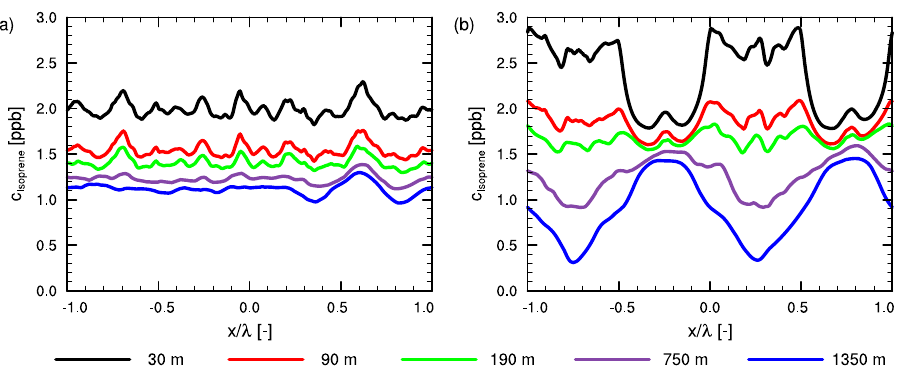
Fig. 5. Isoprene concentrations for the homogeneous case (a) and the heterogeneous case (b) at different heights. The concentrations are averaged over the fourth hour of simulated time and the y-direction. The x-coordinate is scaled by the length scale of heterogeneity, λ , which is twice the patch size. The forest patches are located at − 1 < x